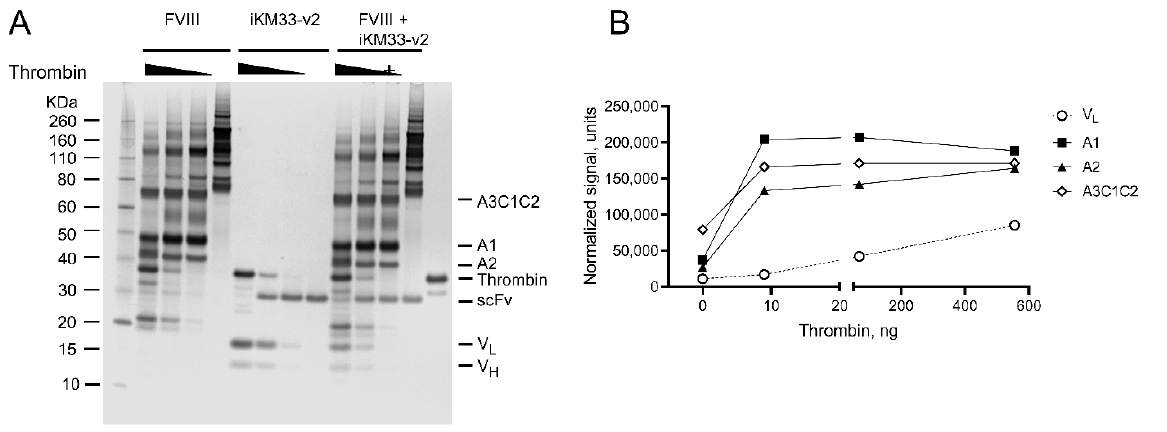
Figure 4. Thrombin cleavage of FVIII and iKM33-v2. ( A ) Samples with FVIII (0.5 µg per sample), iKM33-v2 (0.055 µg per sample), and a mix of FVIII (0.5 µg per sample) and iKM33-v2 (0.055 µg per sample) at a molar ratio of 1:1 were incubated for 10 min with increasing amounts of thrombin (0, 8.7, 69, and 555 ng per sample). The reactions were stopped by PPACK, and the samples were analyzed by SDS-PAGE followed by gel silver staining. The identities of the selected bands are indicated as follows: (i) FVIII fragments: A1, A2, A3-C1-C2, and (ii) iKM33-v2 fragments: scFv—single-chain form, V H and V L subunits. ( B ) Quantitative densitometry of selected FVIII and iKM33-v2 fragments (representative results from one of three experiments).